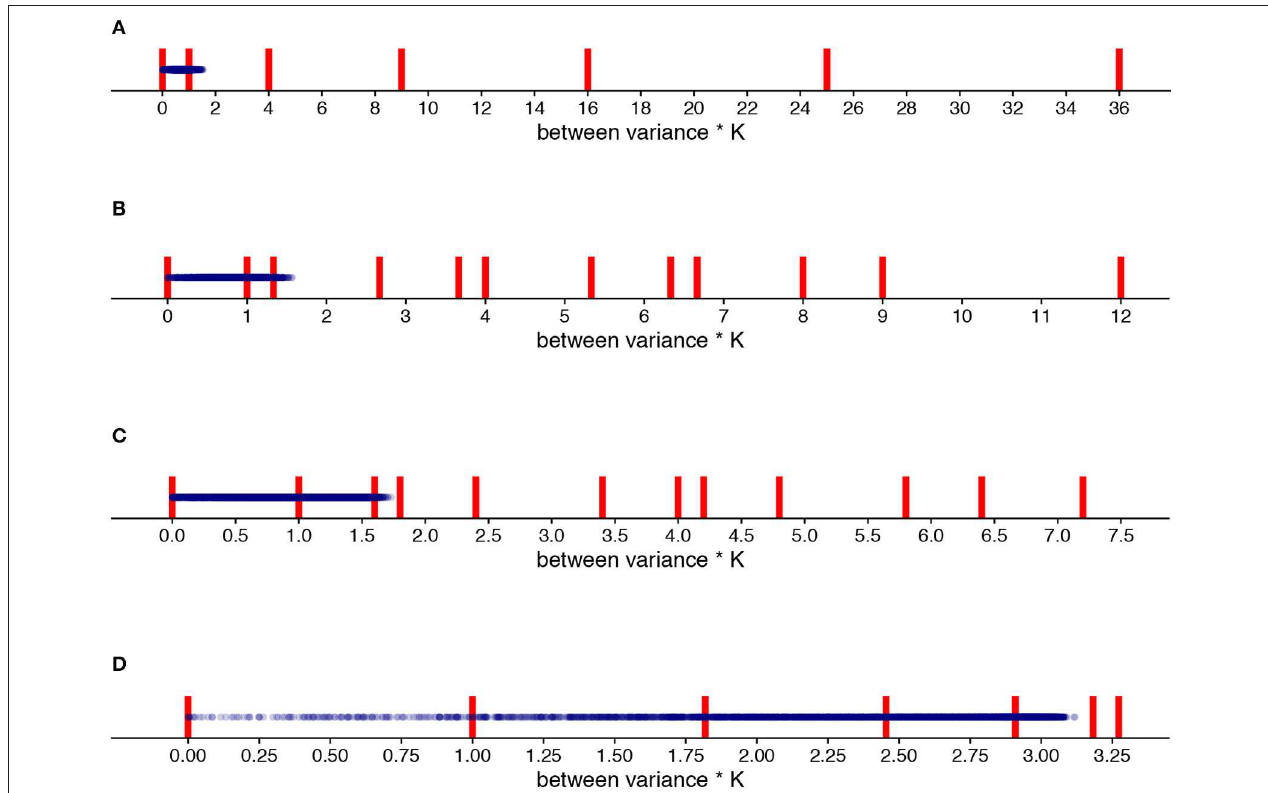
FIGURE 11 | All options of the between variance multiplied by K (red vertical lines; see Equation 11) for K = 2 (A) , K = 4 (B) , K = 6 (C) and K = 12 (D) compared to the “true” truncated and rounded error variances of the 1,000 examinees (blue dots). Note the difference in x-axis